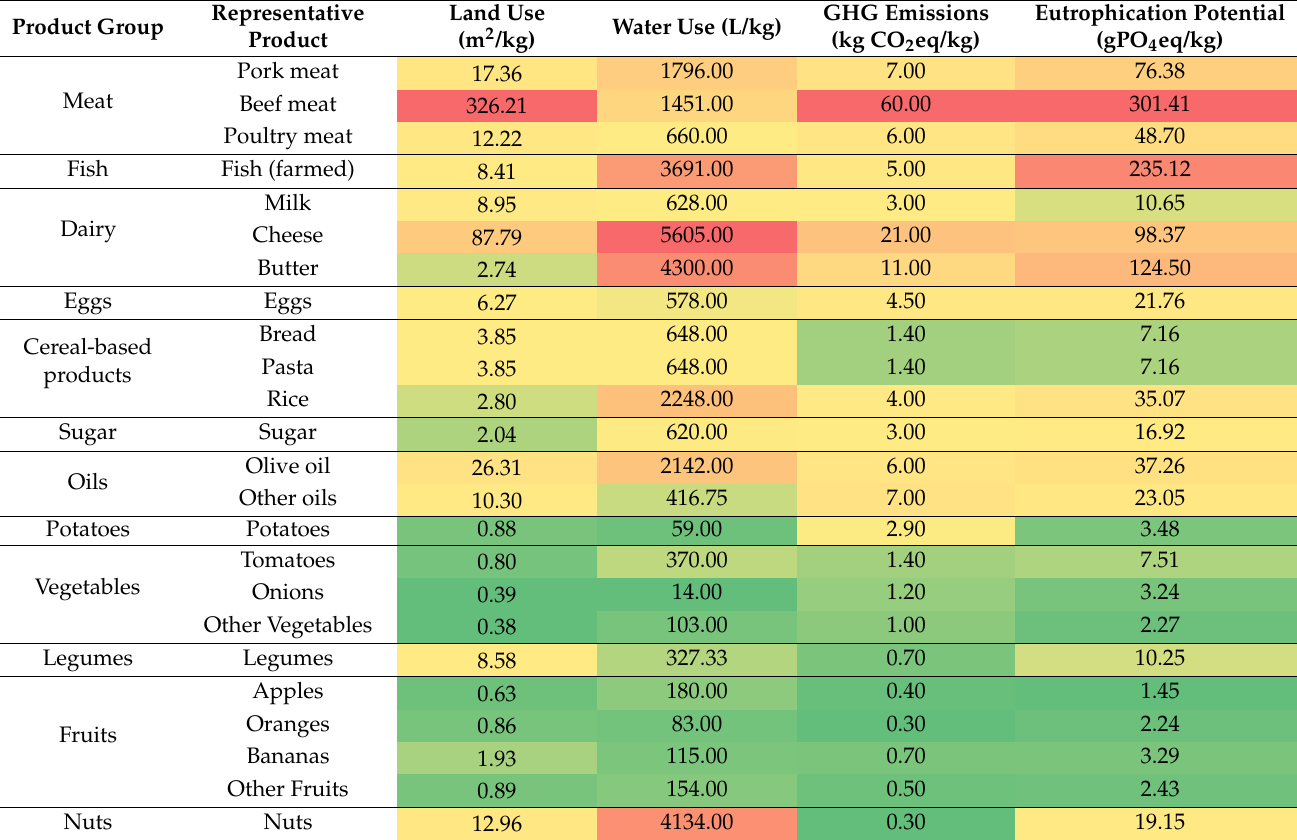
Table 1. Environmental footprints of different food products (global average) in terms of land use, water use, GHG emissions, and eutrophication potential. Colors indicate environmental footprints, from low—green, to light—green, medium—orange, and